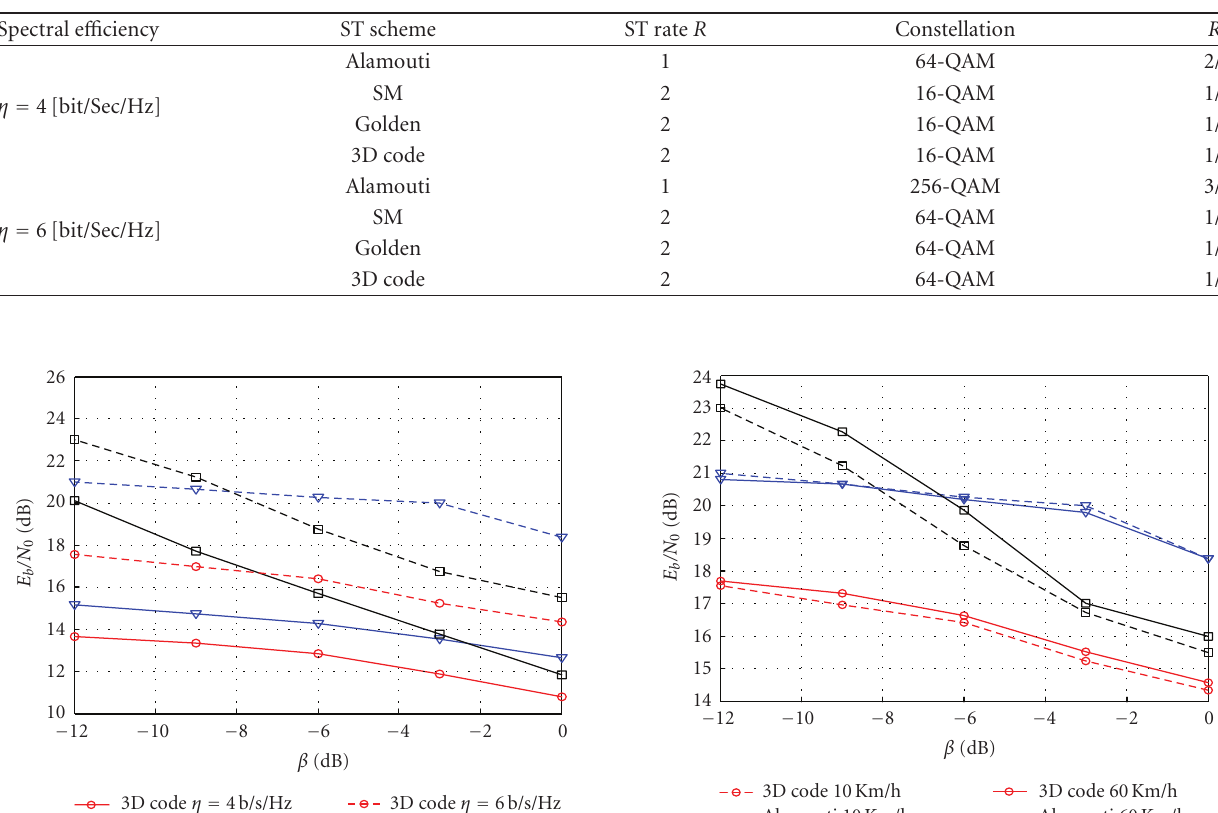
Table 2: Di ff erent MIMO schemes and e ffi ciencies.